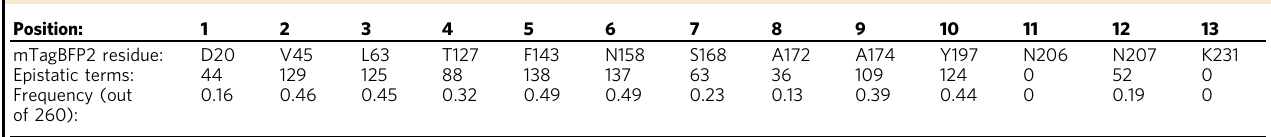
Table 1 Signi fi cant epistatic contributions for mutated